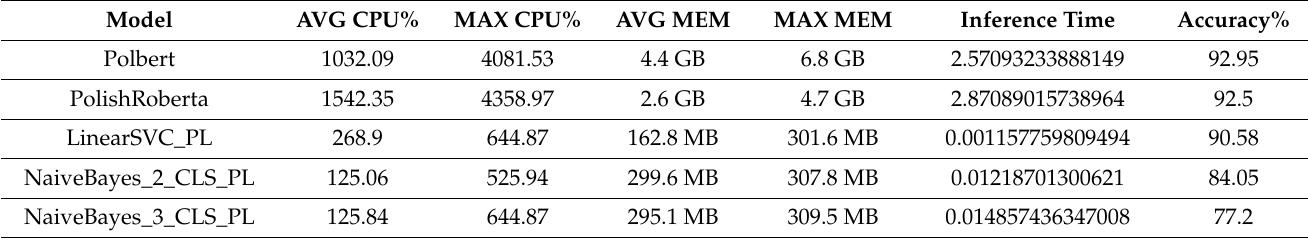
Table 5. The results of experiments for the Polish-language